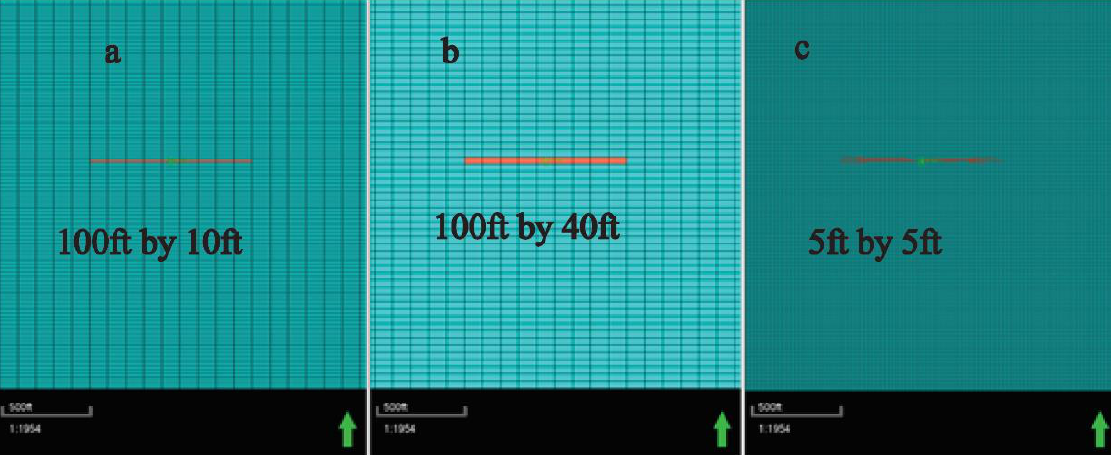
Figure 2. Coarse and coarser gridding for production performance comparison, ( a ) Coarse model 1 ( b ) Coarse model 2, ( c ) Reference sector model.